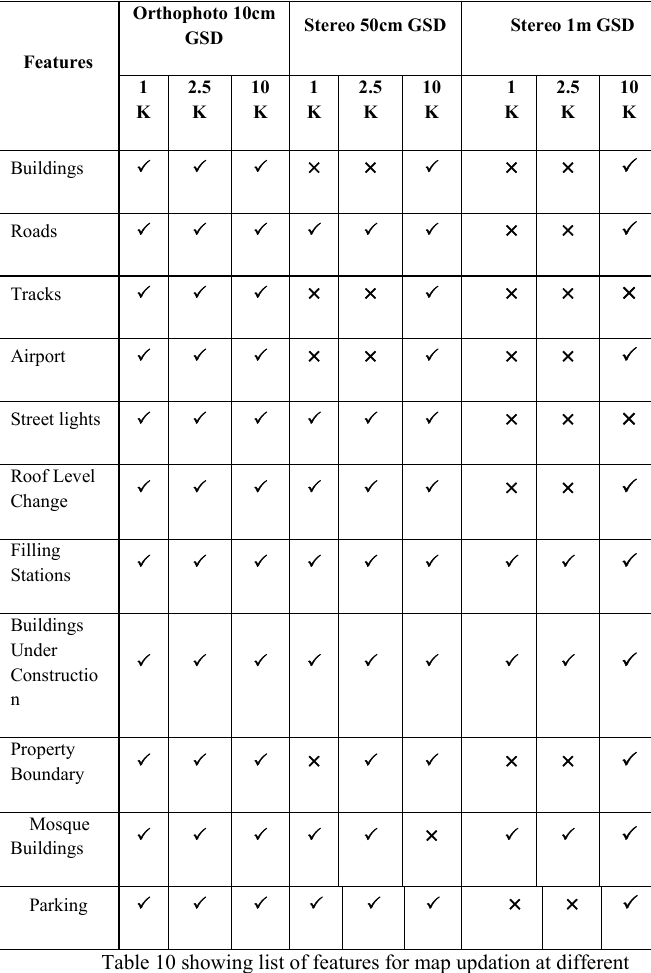
Table 10 showing list of features for map updation at different